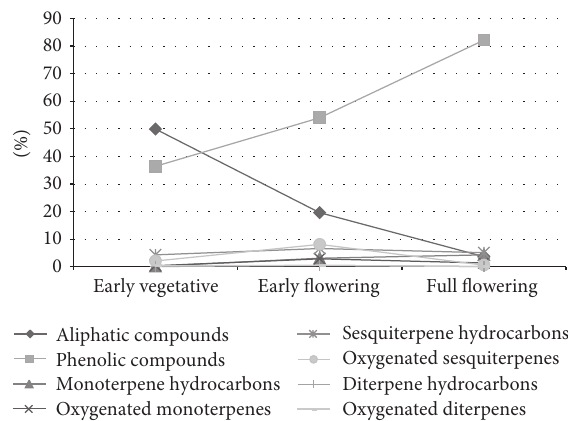
F 1: Percentage variation of the main D. crinitus classes of compounds throughout the vegetative